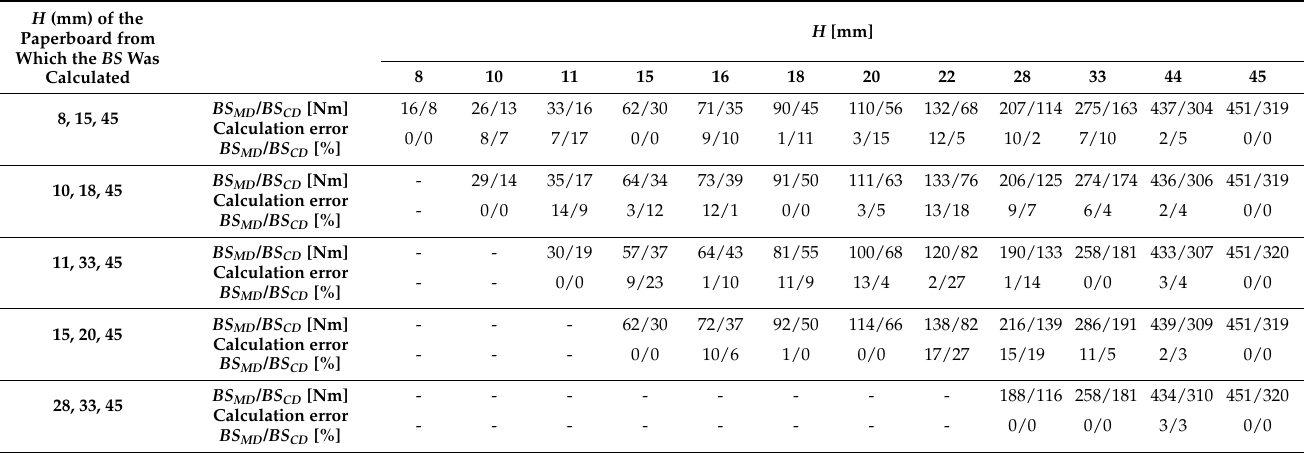
Table 4. Exemplary results of BS MD and BS CD calculations using method II and calculation errors